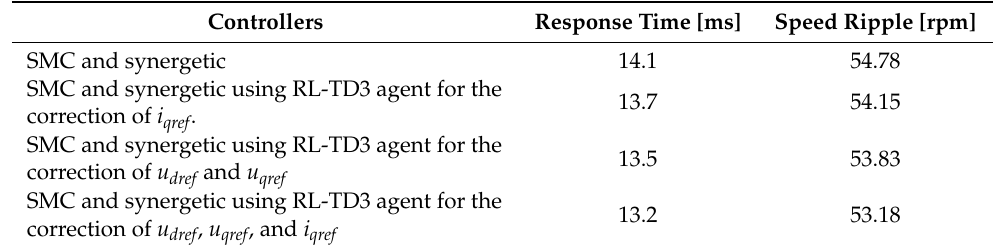
Table 2. PMSM control system based on SMC and synergetic controllers using RL-TD3 agent